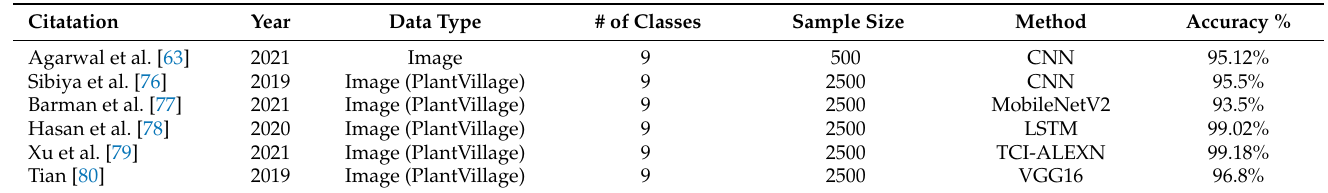
Table 13. Performance comparison of selected studies on machine learning based maize disease detection and corresponding